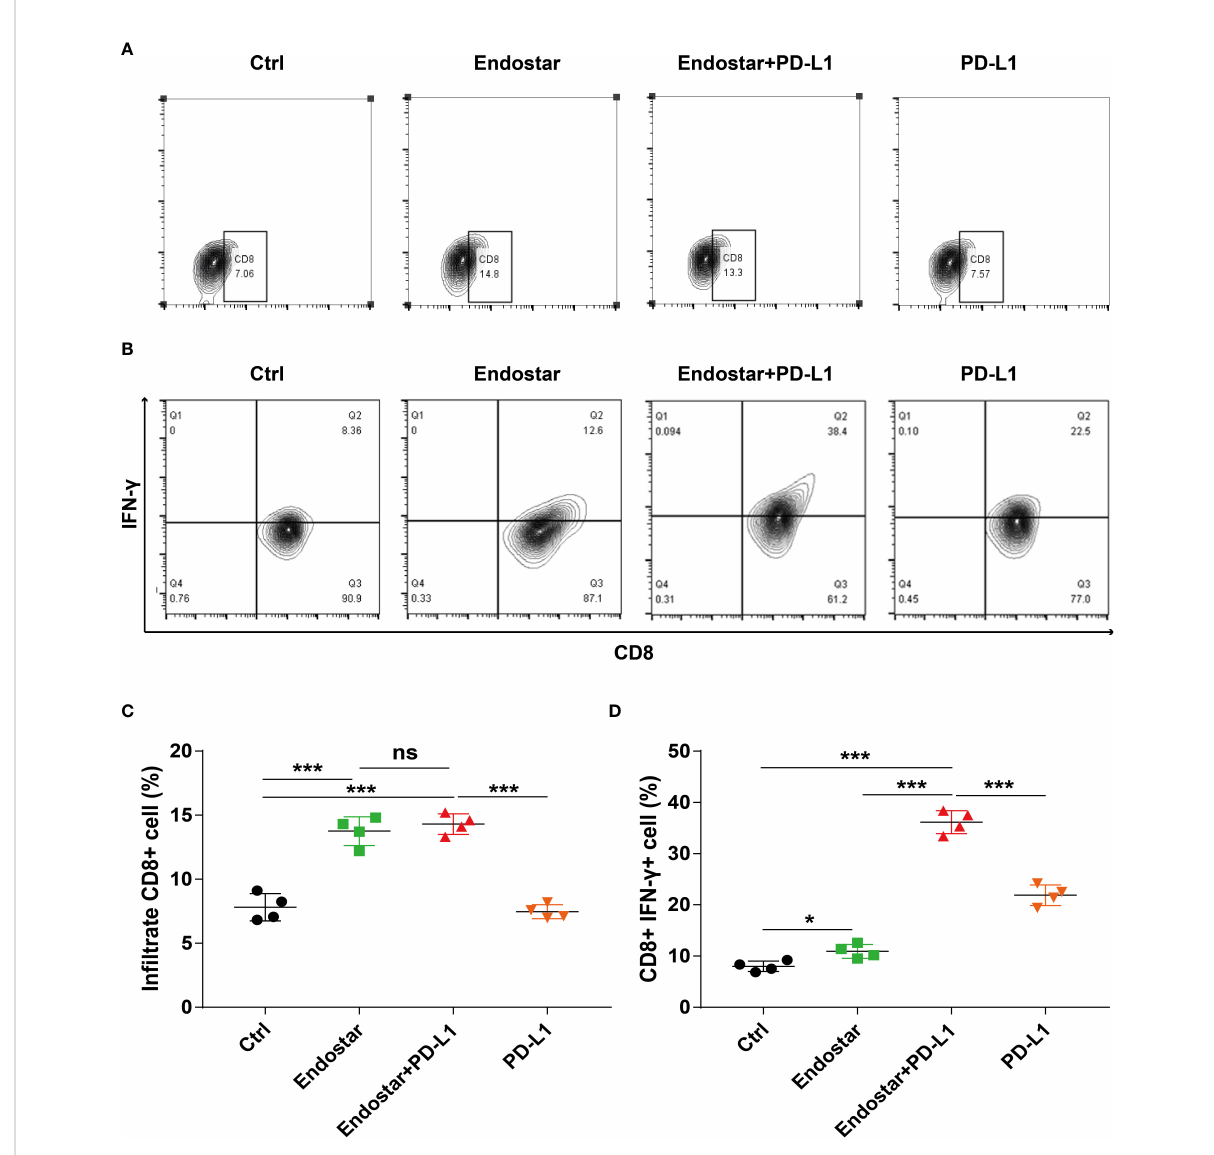
FIGURE 3 Density and function of CD8+ T cells in fi ltrating colorectal cancer detected by fl ow cytometry when recombinant human endostatin is combined with a programmed death ligand-1 (PD-L1) inhibitor. (A) Flow cytometry is used to detect the in fi ltration density of CD8+ T cells in the tumors of the four groups of mice. (B) The proportion of interferon (IFN)- g -positive cells of CD8+ T cells in the tumors of the four groups of mice is detected by fl ow cytometry. (C) Comparison of the in fi ltration density of CD8+ T cells in the tumors of the four groups of mice. (D) Comparison of the proportion of IFN- g -positive CD8+ T cells in the tumors of the four groups of mice (*P<0.05; ***P< 0.001). ns, not signi fi cant,